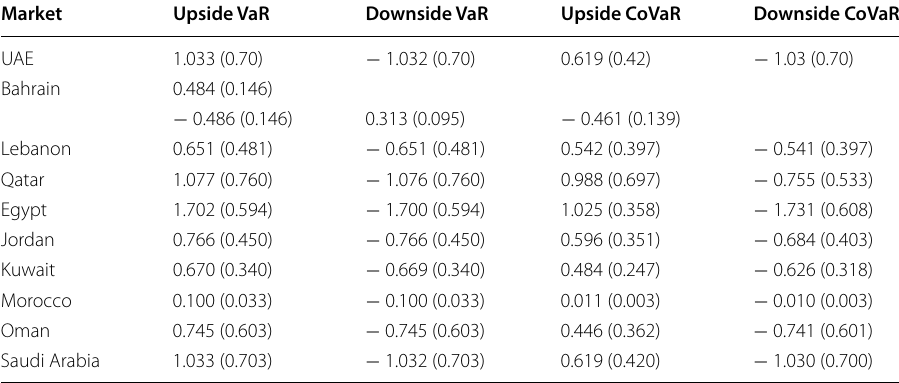
Table 3 Summary value at risk and conditional value at risk statistics for stock markets in the MENA